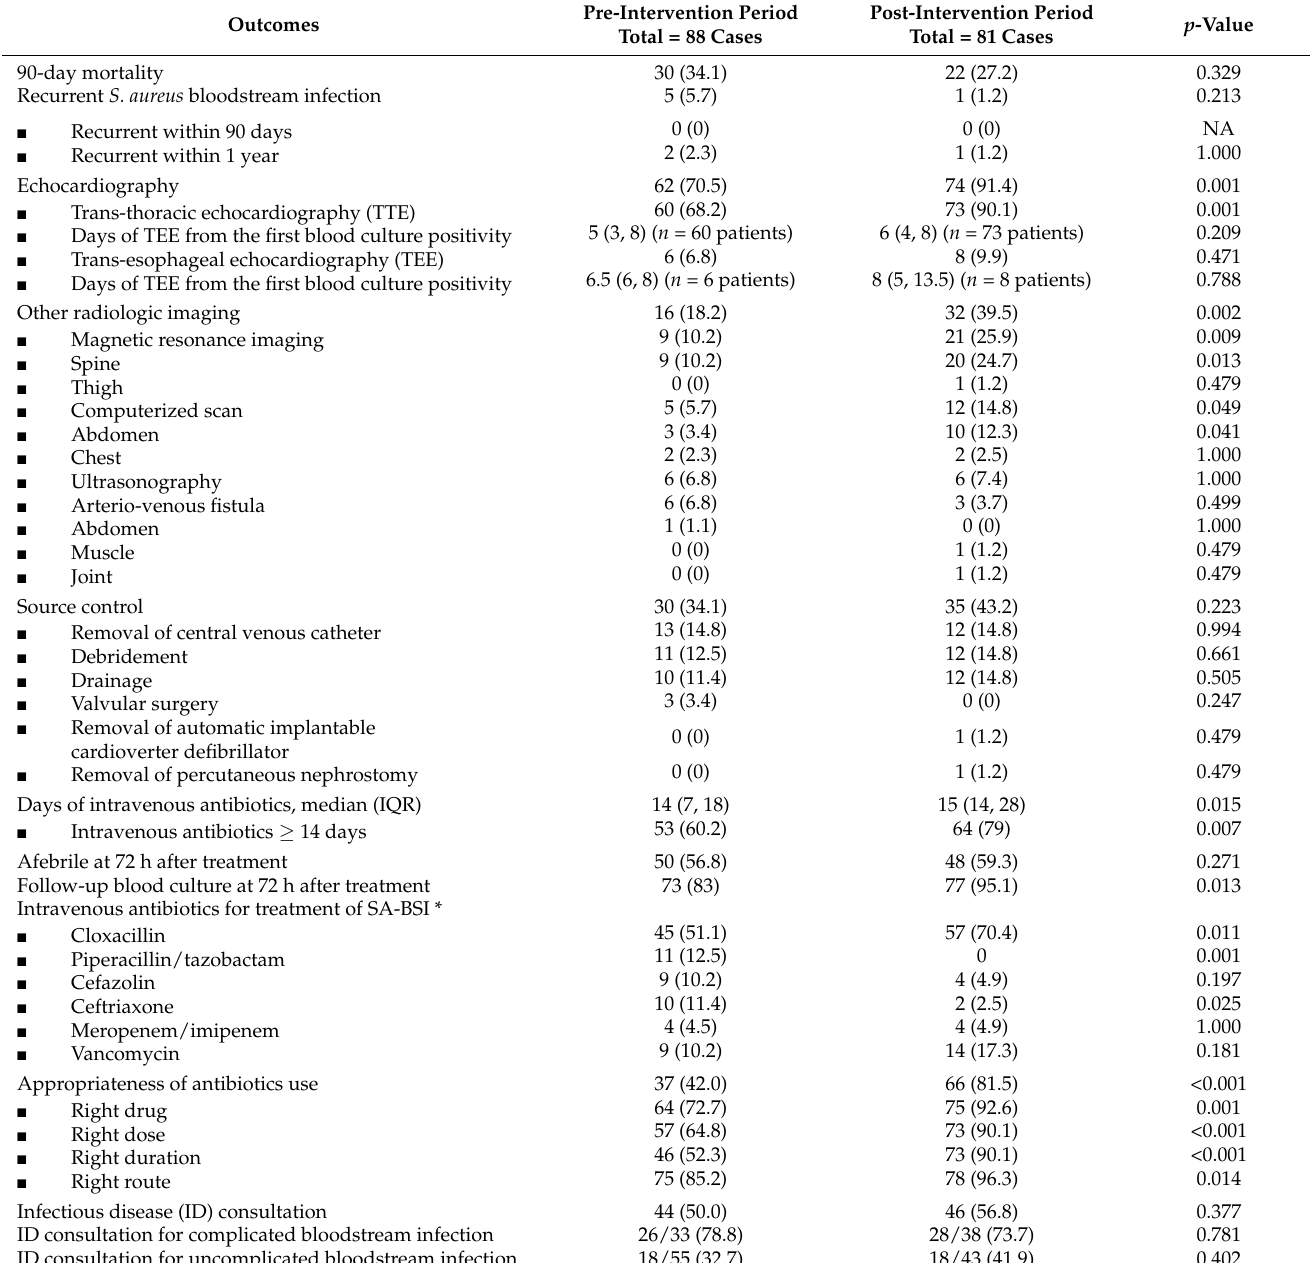
Table 3. Outcomes and management for patients before and after implementation of Staphylococcus aureus bloodstream infection treatment